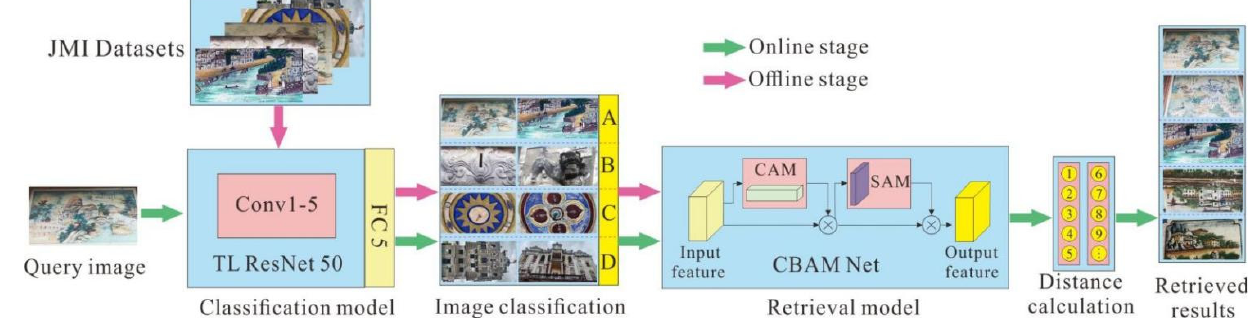
Figure 3. Block diagram of Diaspora Chinese architectural heritage image classification and retrieval.